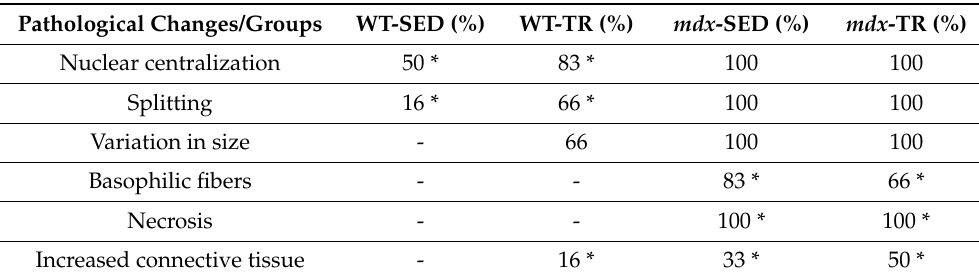
Table 1. Semiquantitative analysis of pathological changes in the psoas fibers identified by hema- toxylin and eosin.